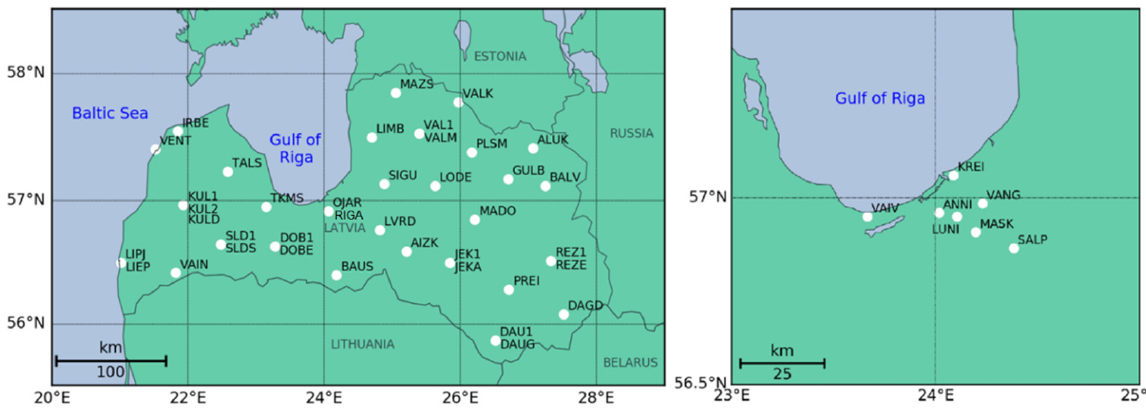
Figure 2. A schematic map of LatPos and EUPOS-RIGA networks and IGS/ EPN station RIGA. Over 11 years, the total number of months included in the analysis reached 46. For 2015 and 2017, 5-month observation data were analyzed, compared to 4-month observation data in each of all the other 9